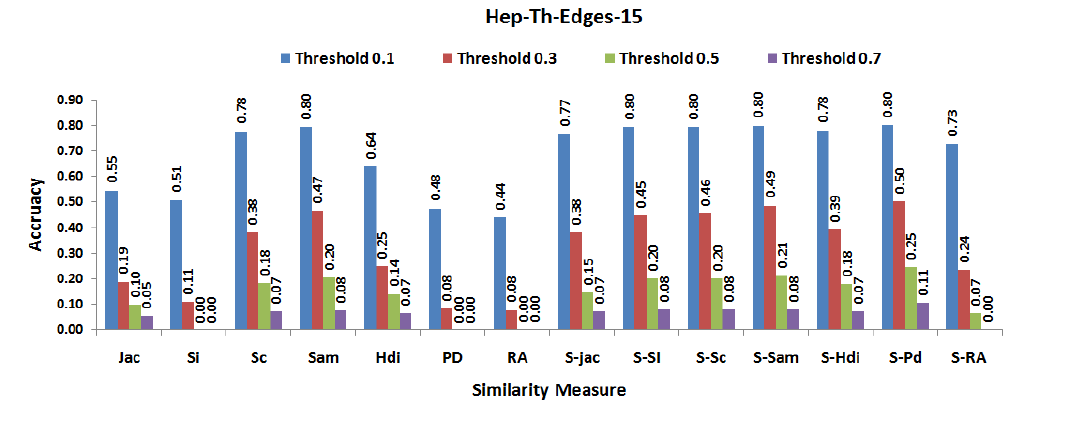
Figure 13. Prediction Results using HepTh Dataset with 15% Edges and S-PD obtained maximum accuracy by 0.81 and both SI, PD and RA achieved minimum accuracy by